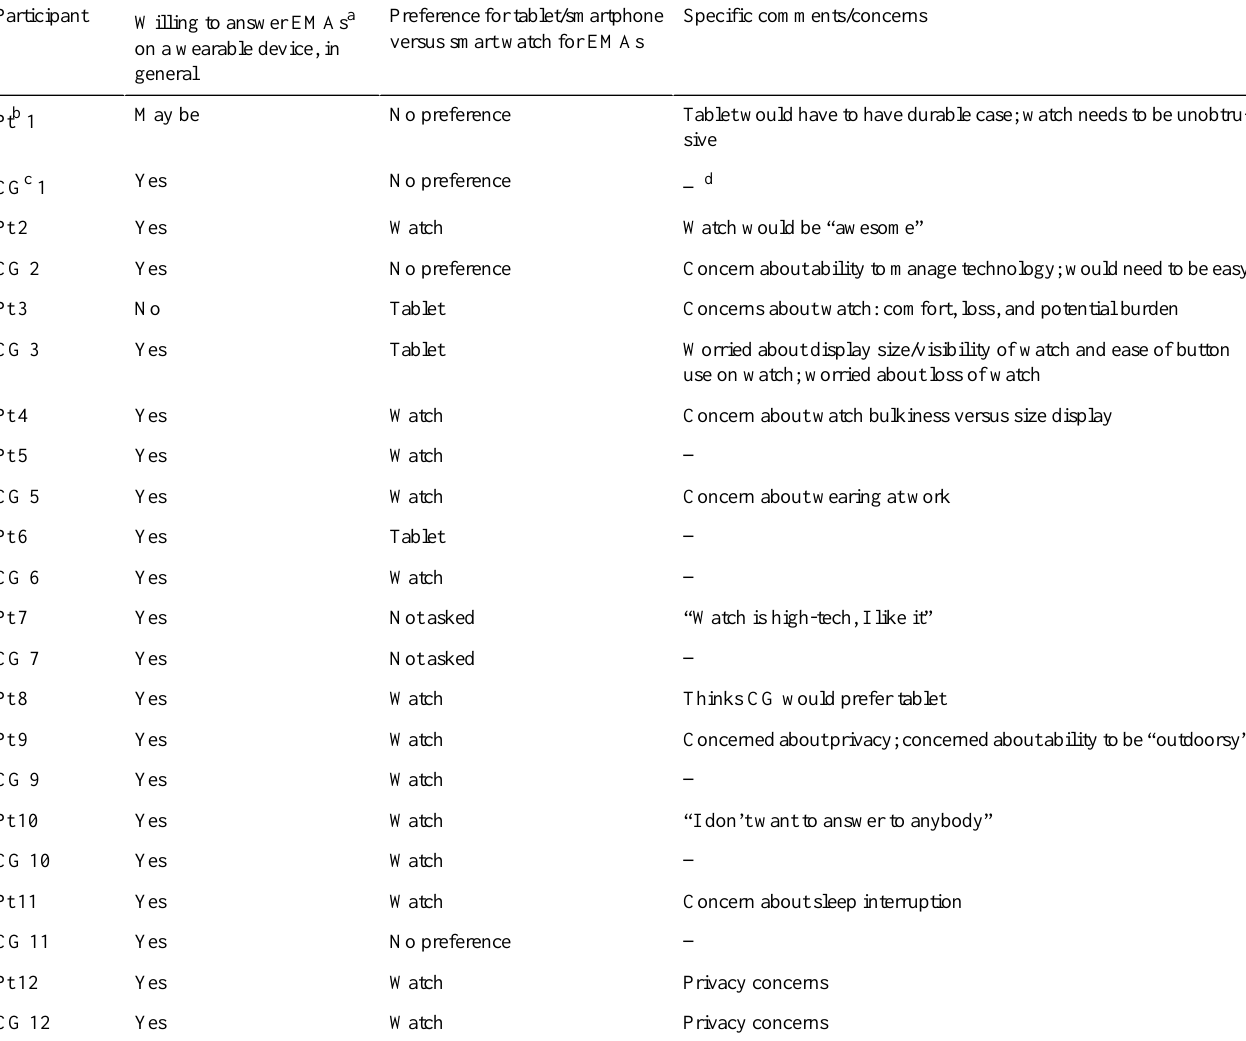
Table 5. Participant preferences and concerns regarding a wearable device to answer ecological momentary assessments.